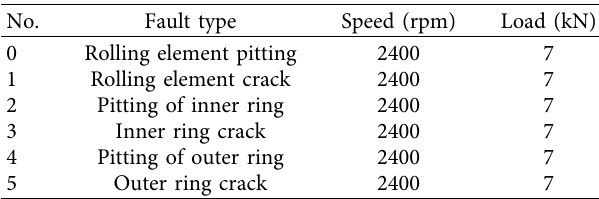
Table 2: Fault details.